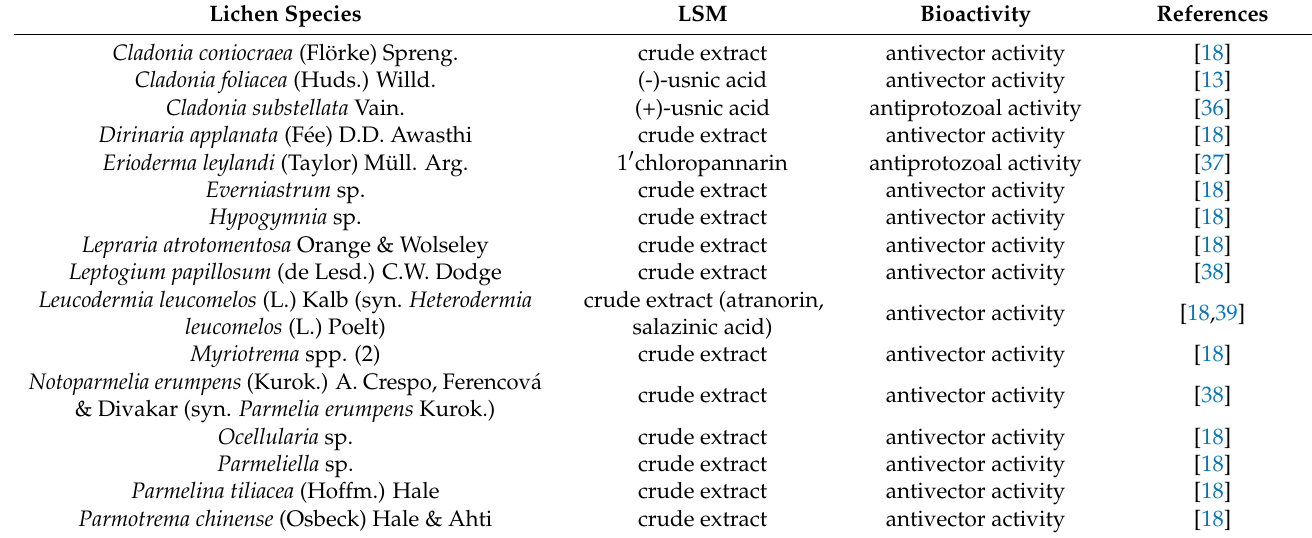
Table 1. Lichen species and LSMs having antivector or antiprotozoal bioactivity (N/A = not available). Lichen